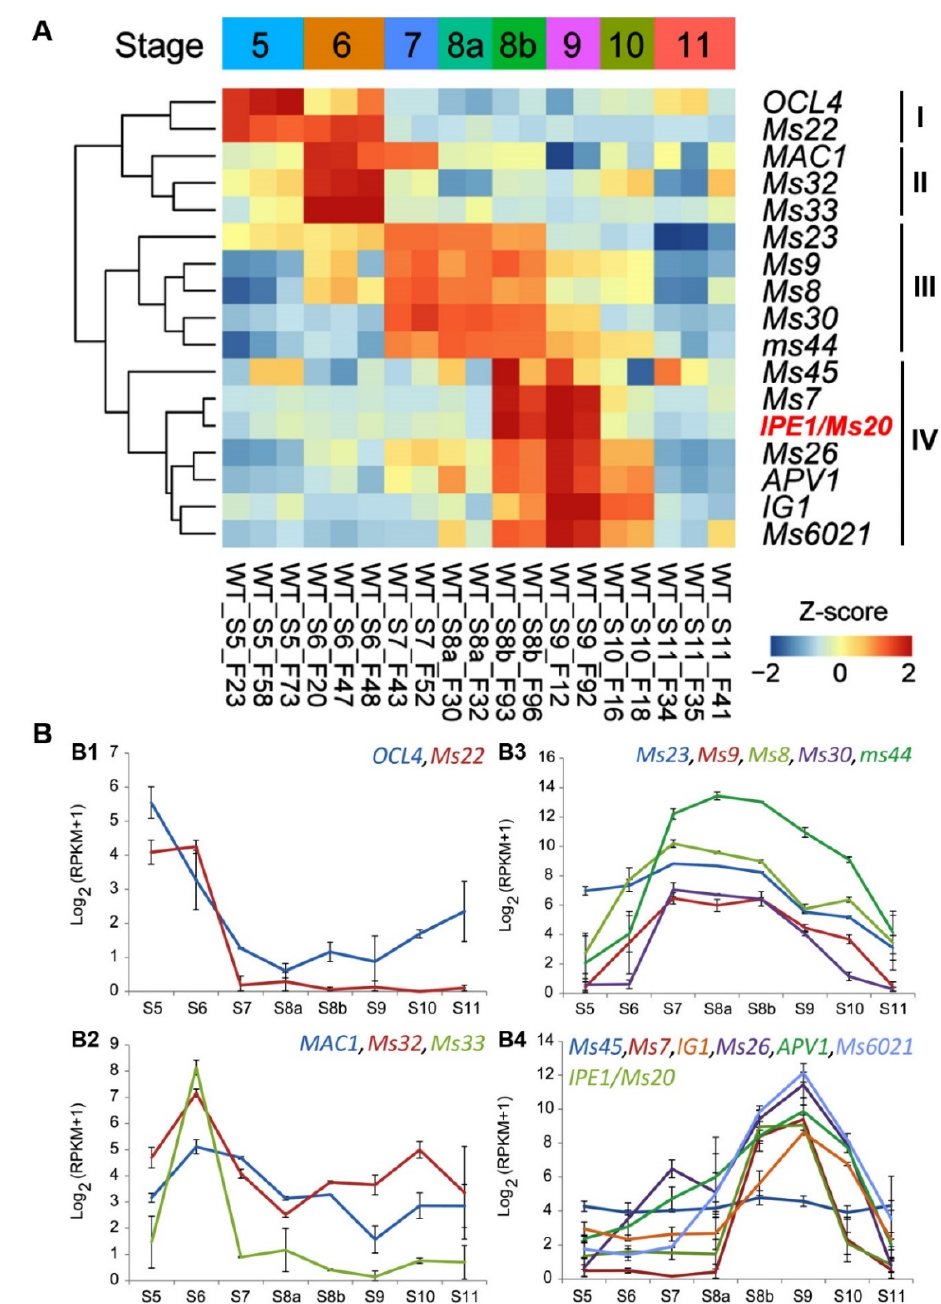
Figure 5. Expression patterns and classification of 17 GMS genes cloned in maize. ( A ) Hierachical clustering of the 17 cloned GMS genes based on RNA-seq data during eight anther developmental stages (S5 to S11). These GMS genes are clustered into four clades in chronological order of gene expression. Among them, ZmMs20 / IPE1 is clustered into the clade IV. ( B ) Expression patterns of the GMS genes in clade I ( B1 ), clade II ( B2 ), clade III ( B3 ), and clade IV ( B4 ). 2.6. Two Co-segregating Functional Markers Developed for Creating ms20 Male-sterility Lines by